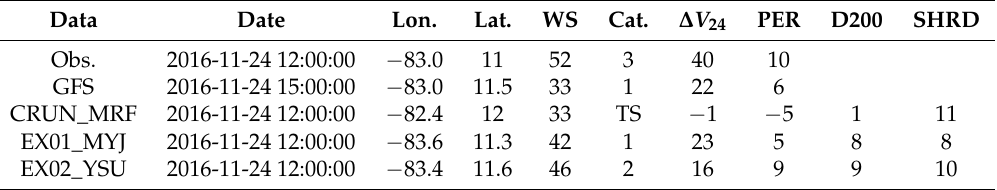
Table 3. Mean magnitudes of RI predictors estimated for the Hurricane Otto observations and simulations using the GFS and WRF-ARW model for the 25-knot threshold. GFS is the Global Forecasting System model. CRUN_MRF, EX01_MYJ, and EX02_YSU are: the control-run using the Medium Range Forecast, the Mellor-Yamada-Janjic and the Yonsei University schemes, respectively. The columns are WS: wind speed (m s − 1 ), Cat: Saffir-Simpson scale, ∆ V 24 : change in the surface wind in at least 24-h (m s − 1 ), PER: previous 12-h change in intensity of the surface wind (m s − 1 ), D200: horizontal wind divergence at 200 hPa (1 × 10 − 5 s − 1 ) and SHRD: the vertical wind shear between 850 and 200 hPa (m s − 1 ).